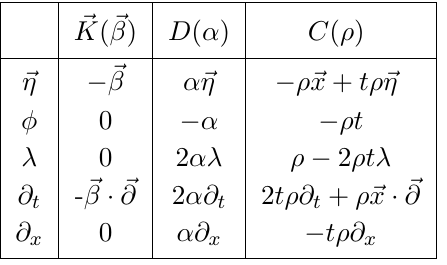
Table 1 . In(cid:12)nitesimal variation of Goldstones under broken